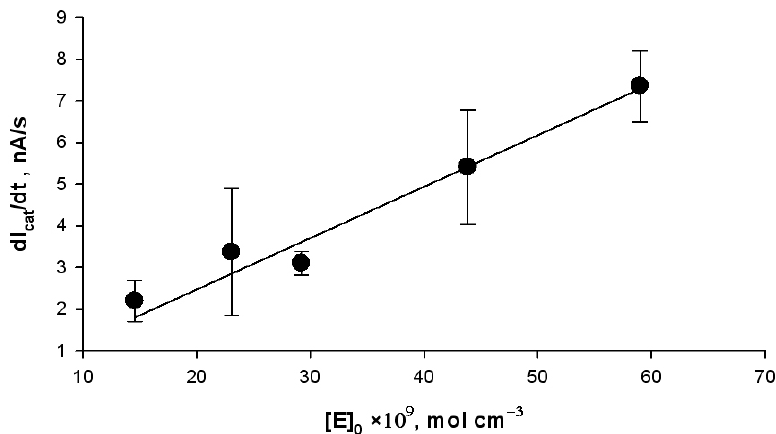
Figure 2. Dependence of the initial rate of AAP hydrolysis on the total TLL concentration. The solid line describes computed results, the filled circles with error bars – experimental data from [7]. For the experimental conditions, see Section 2 of this study. In both cases, [S] =1.7×10 -11 mol cm -2. 0